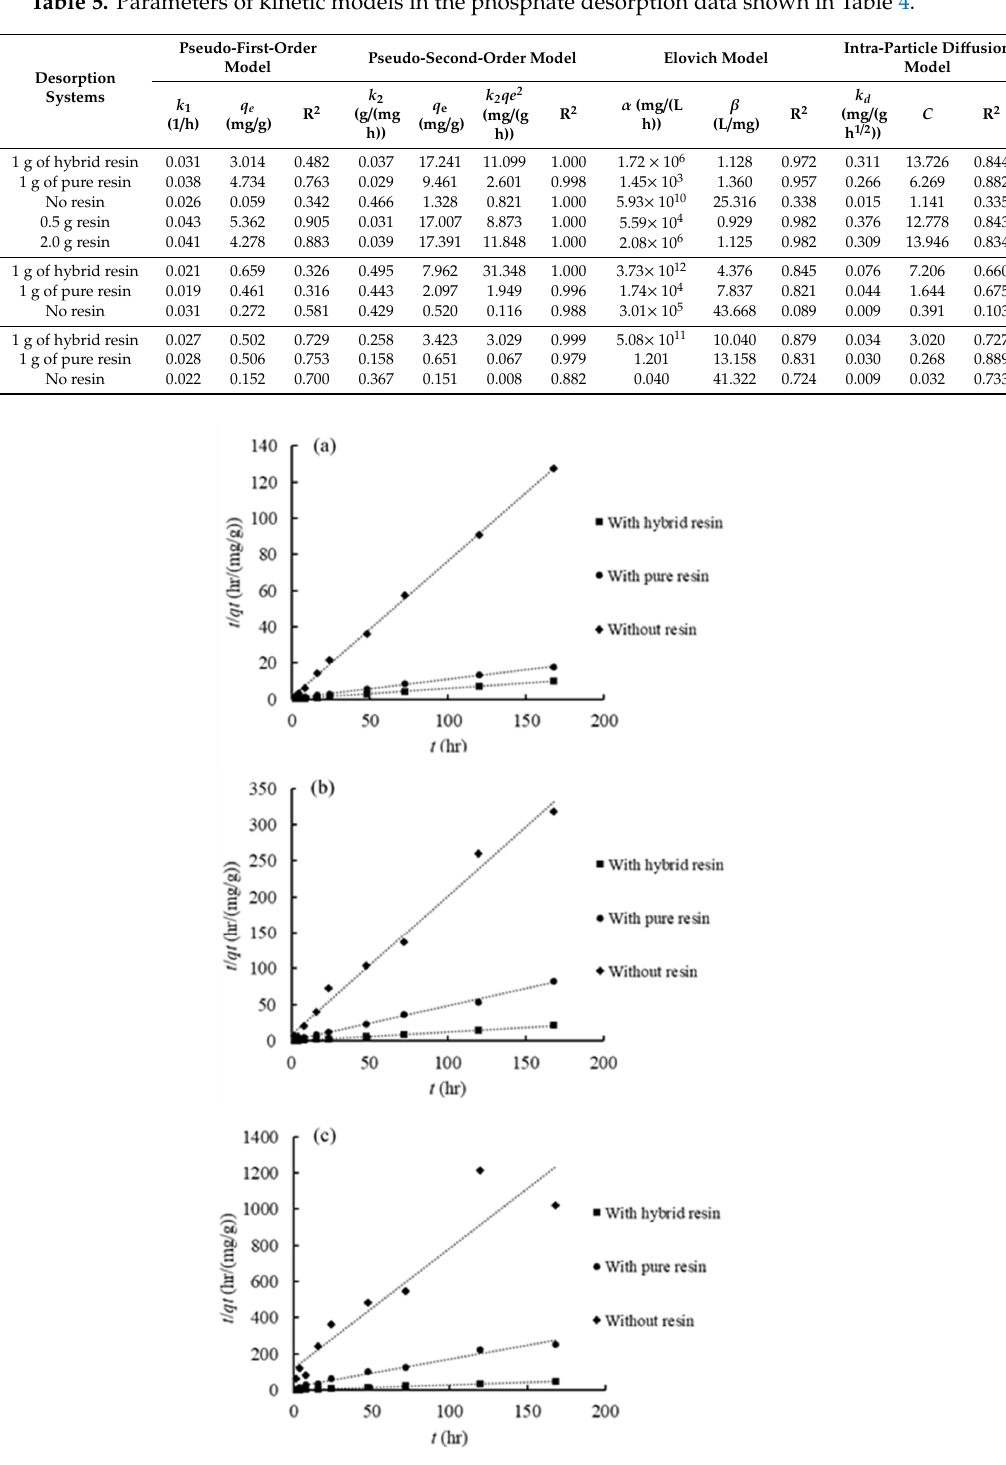
Figure 6. Linear plot of pseudo-second-order model for the phosphate desorption data shown in Figure 5. ( a ) S_18, ( b ) S_90, ( c ) S_180. (1) Pseudo-First-Order Model and Pseudo-Second-Order Model